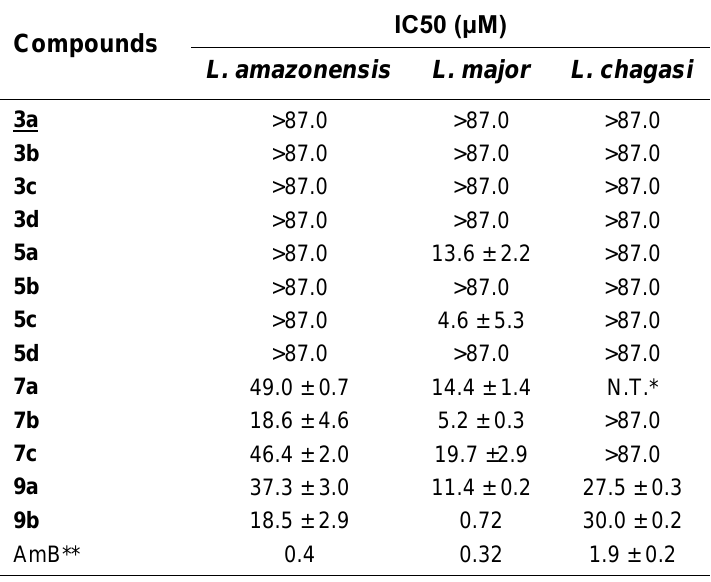
In vitro 50% Inhibitory Activity against Promastigotes of Three Leishmania Species